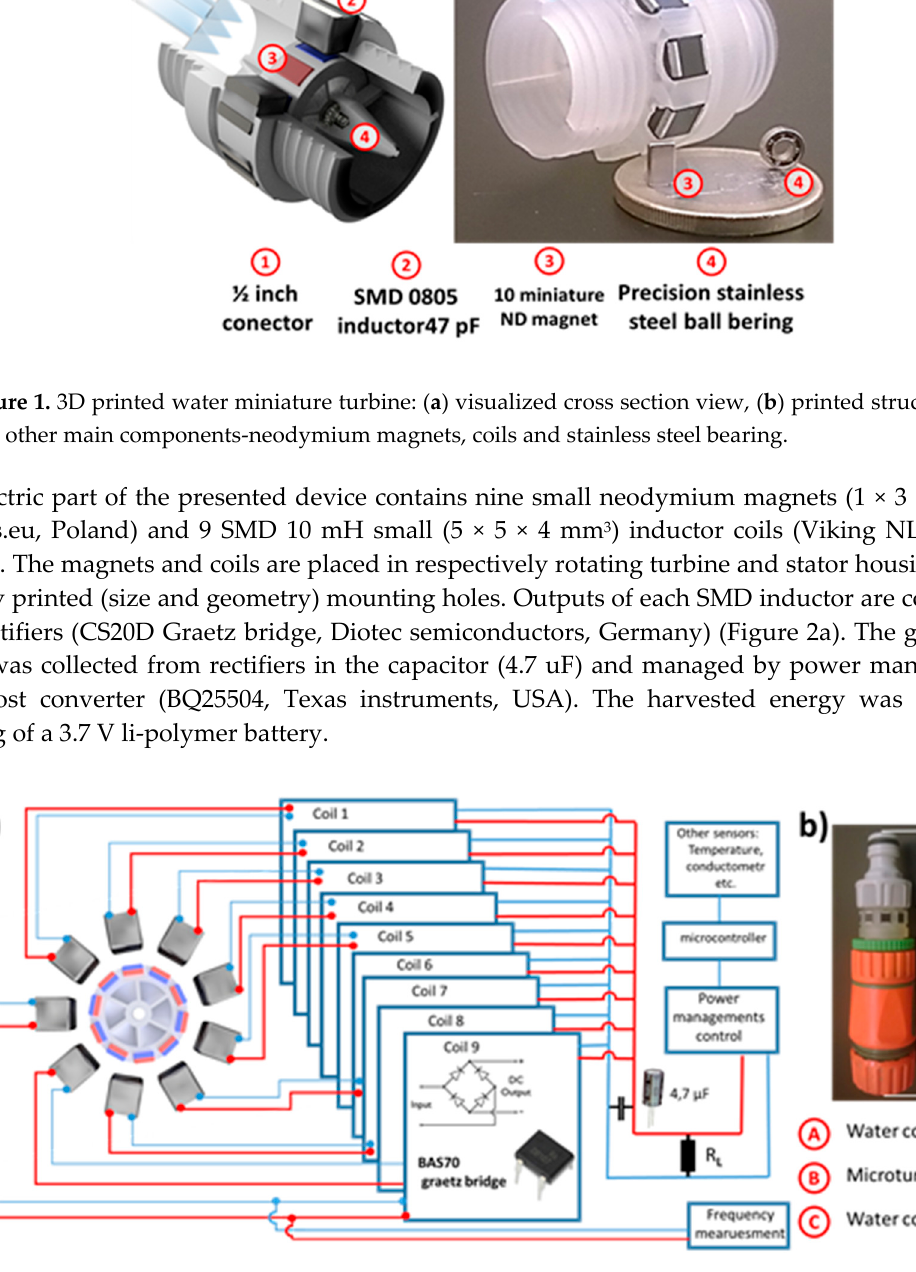
Figure 2. Miniature turbine energy harvester scheme ( a ) and view of the harvester as a part of garden water pipe ( b